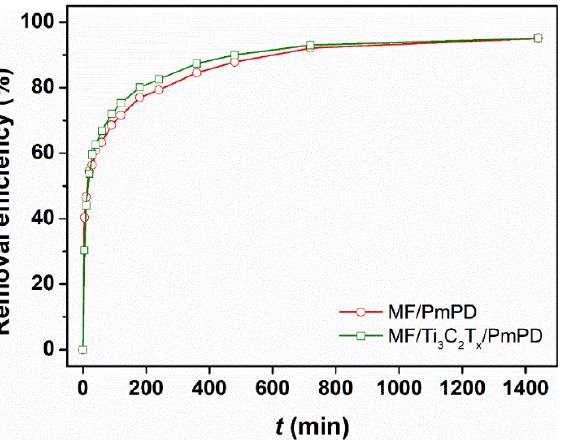
Figure 9. Effect of contact time on the Cr(VI) removal efficiency of MF/PmPD and MF/Ti 3 C 2 T x /PmPD (initial Cr(VI) concentration: 100 mg/L, dosage: 0.5 g/L, pH = 2, temperature: 25 °C). In order to systematically understand the dynamic adsorption process of Cr(VI) by MF/Ti 3 C 2 T x /PmPD and MF/PmPD, pseudo-first-order kinetic model, pseudo-second-or-